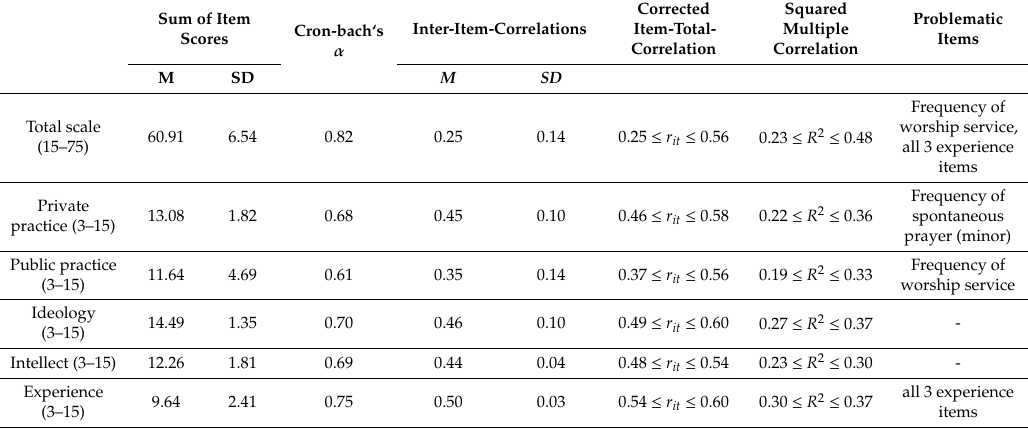
Table 1. Study 1: Summary of the results of the reliability analysis of the Centrality of Religiosity Scale (CRS) and its subscales. Sum of Item Scores Cron-bach‘s α Inter-Item-Correlations